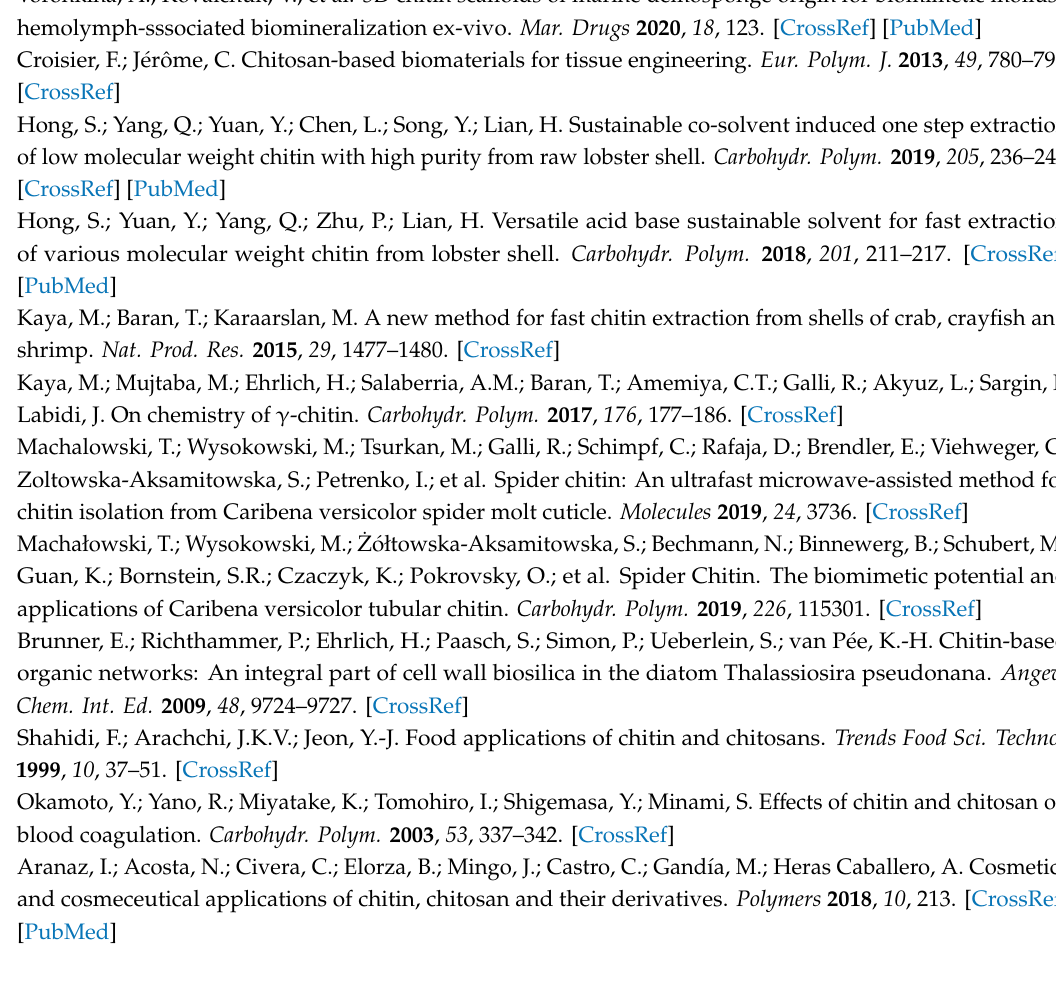
Figure S1: Morphology of pristine chitin; Figure S2: Droplet morphology of emulsions stabilized with di ff erent ChNCs concentrations (a) 0.5%, (b) 0.3%, and (c)